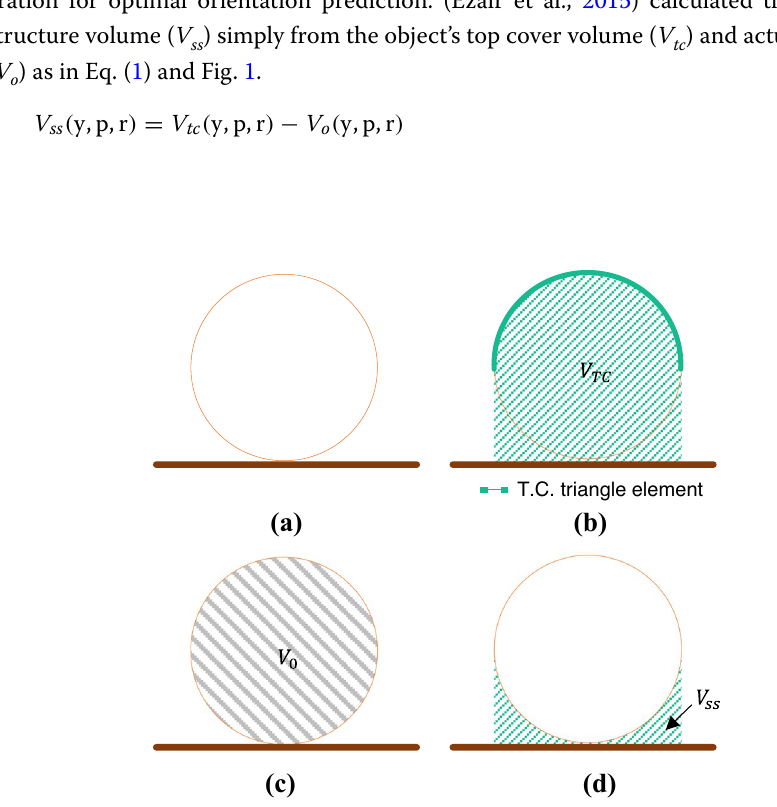
Fig. 1 Shadow-casting based support structure calculation scheme (Ezair et al., 2015). a Target object, b Calculating top-cover volume using GPU, c calculating object volume, d final support structure